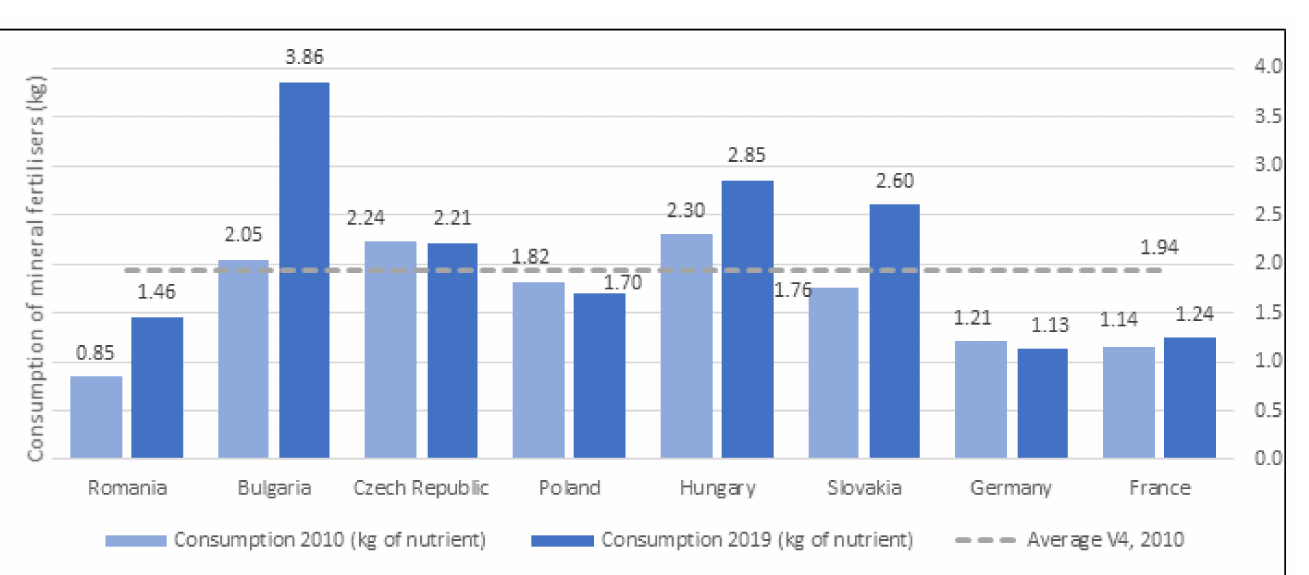
Figure 2. Consumption of mineral fertilisers per 1 kg of manure and other organic fertilisers. Source: own calculation based on